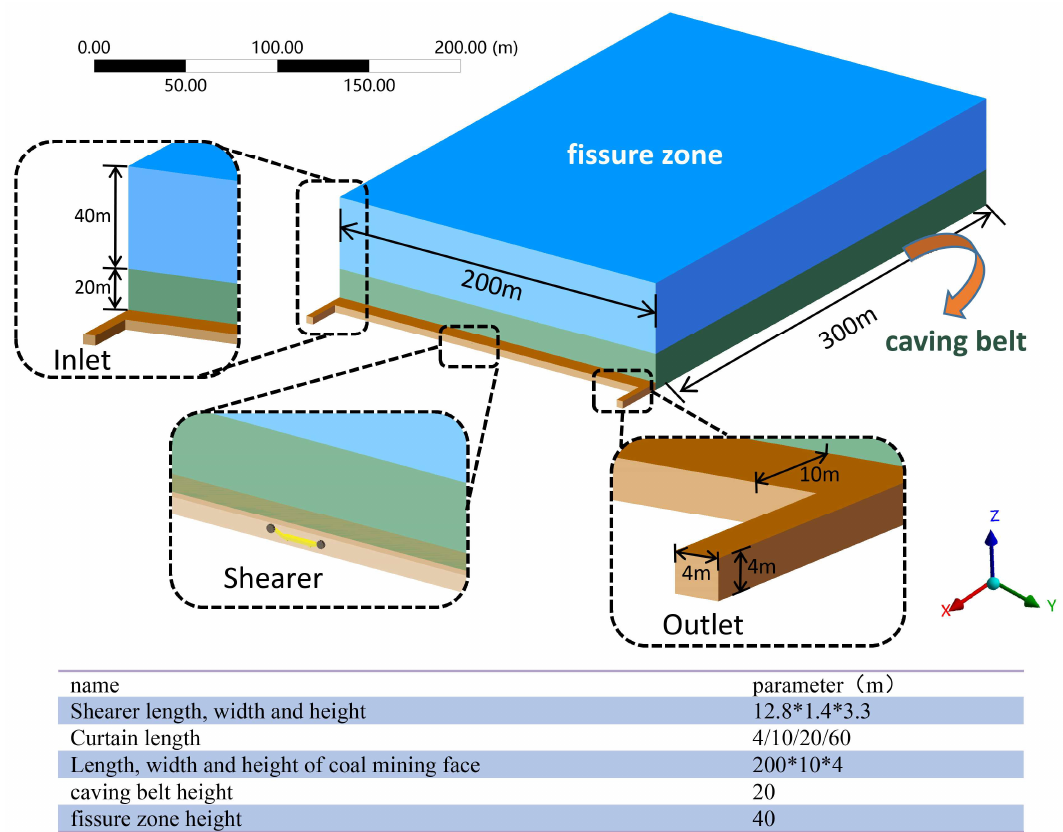
Figure 1. 12,302 coal mining face 3D model size Figure 1. 12302 coal mining face 3D model size drawing.